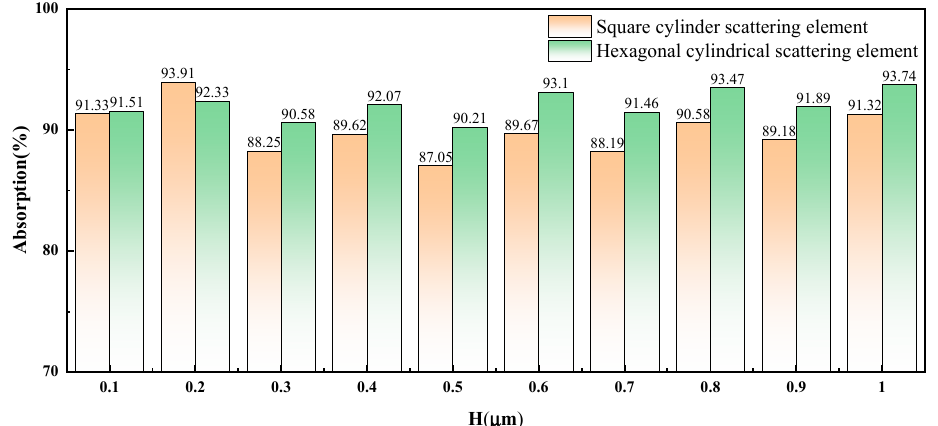
Figure 8. The effect of thickness H for two different types of scatterers on the absorption efficiency of the absorption layer.